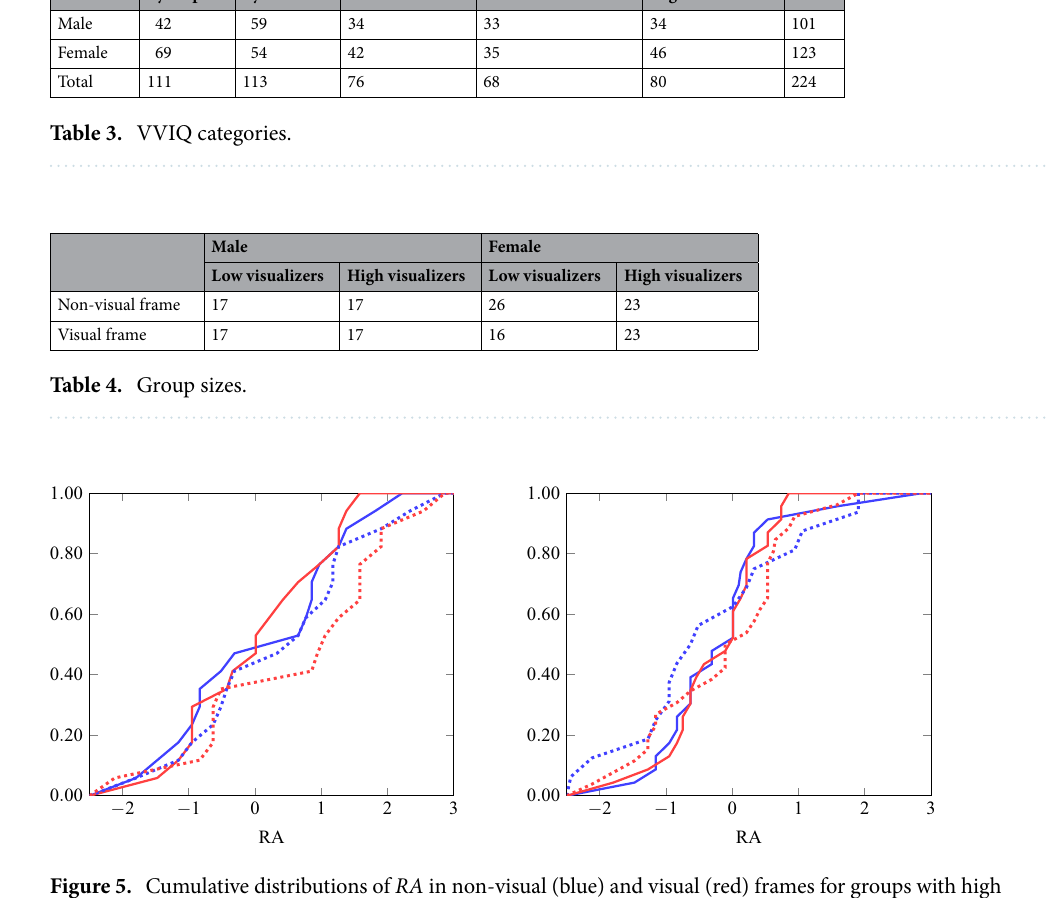
Figure 5. Cumulative distributions of RA in non-visual (blue) and visual (red) frames for groups with high (solid) and low (dotted) visual imagery skills for males (left) and females